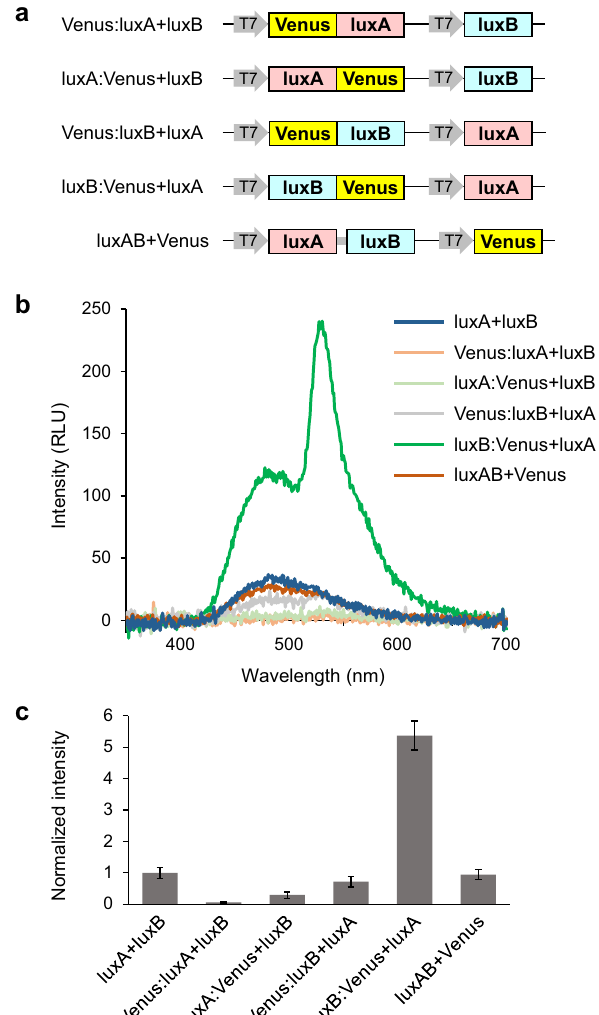
Figure 2. Brightness of luciferase variants fused to Venus. ( a ) Schematic representation of expression constructs in pRSET B vector. ( b ) Luminescence spectra measured in the whole cell suspensions of JM109(DE3) expressing the recombinant proteins from each construct. The luminescence reaction was initiated by the addition of 1% decanal. ( c ) Luminescence intensities of the whole cell suspensions expressing recombinant proteins. Data are means ± SD of three different